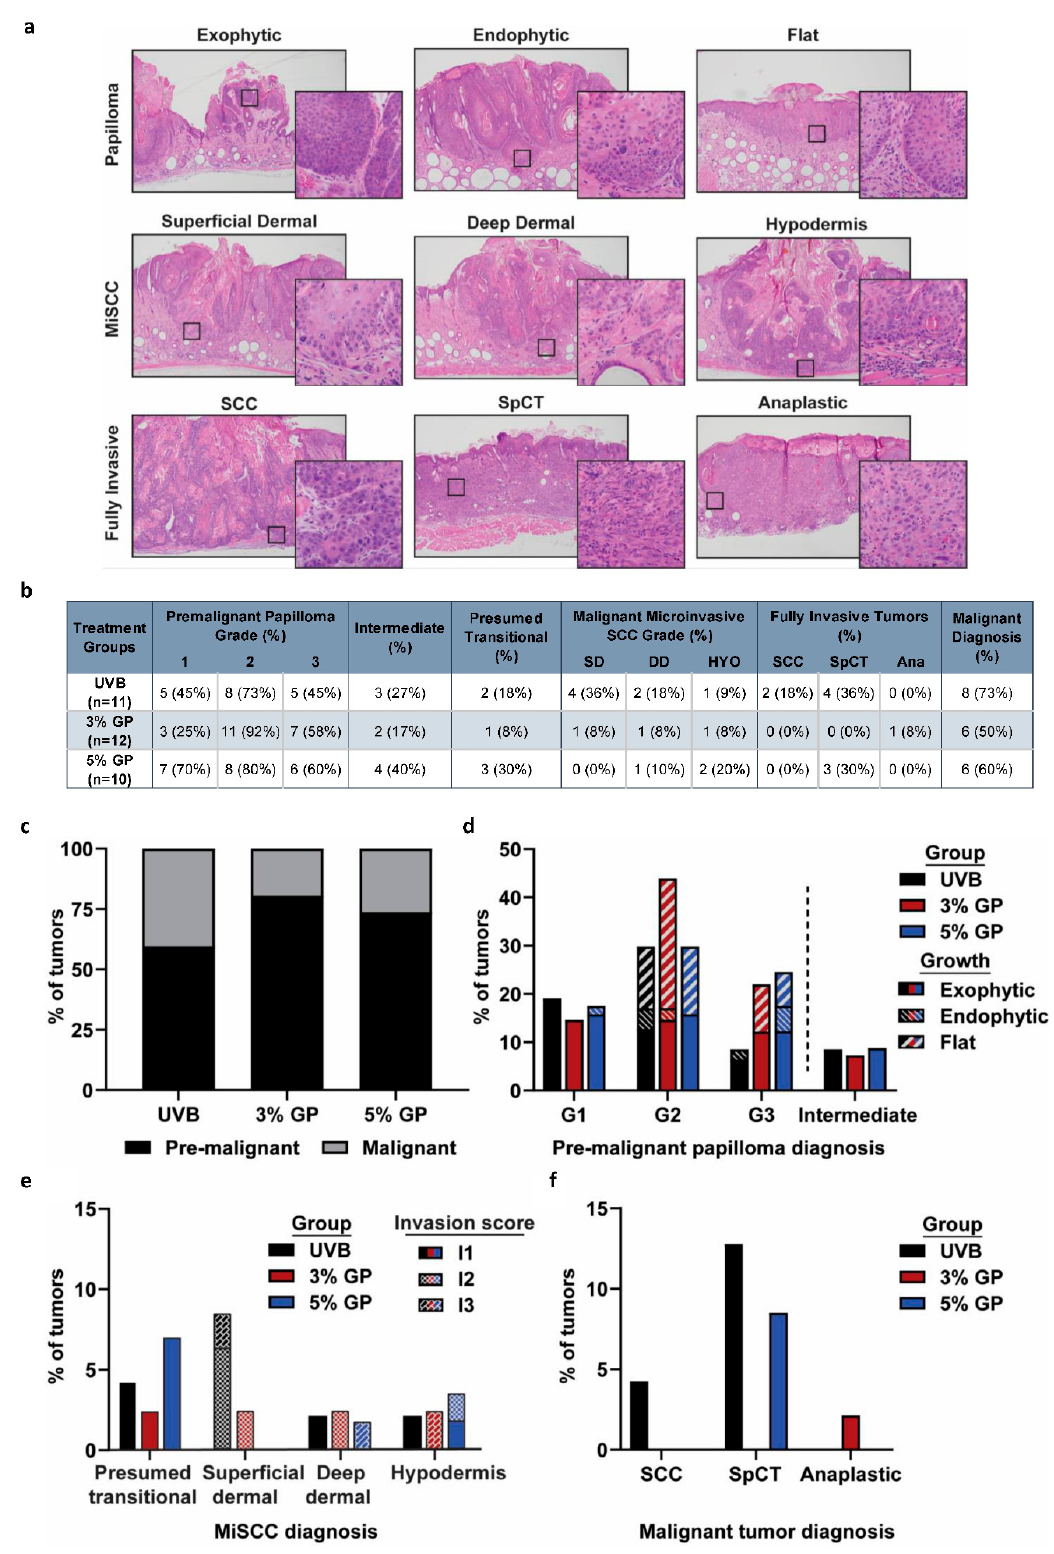
Figure 3. Dietary GP consumption reduces malignant conversion of tumors in UVB-treated SKH-1 hairless mice. ( a ) Images of exemplar lesions of each diagnostic category of tumors. ( b ) Percentages of mice within each treatment group exhibiting lesions in each of the histologic-based classes. ( c ) Tumor diagnoses fell into two categories of premalignant (black) or malignant (grey) tumors. ( d )